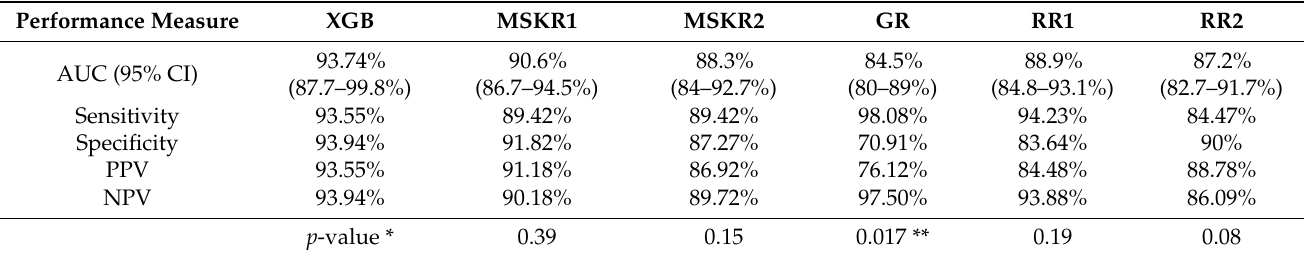
Table 3. Comparison of XGboost to expert